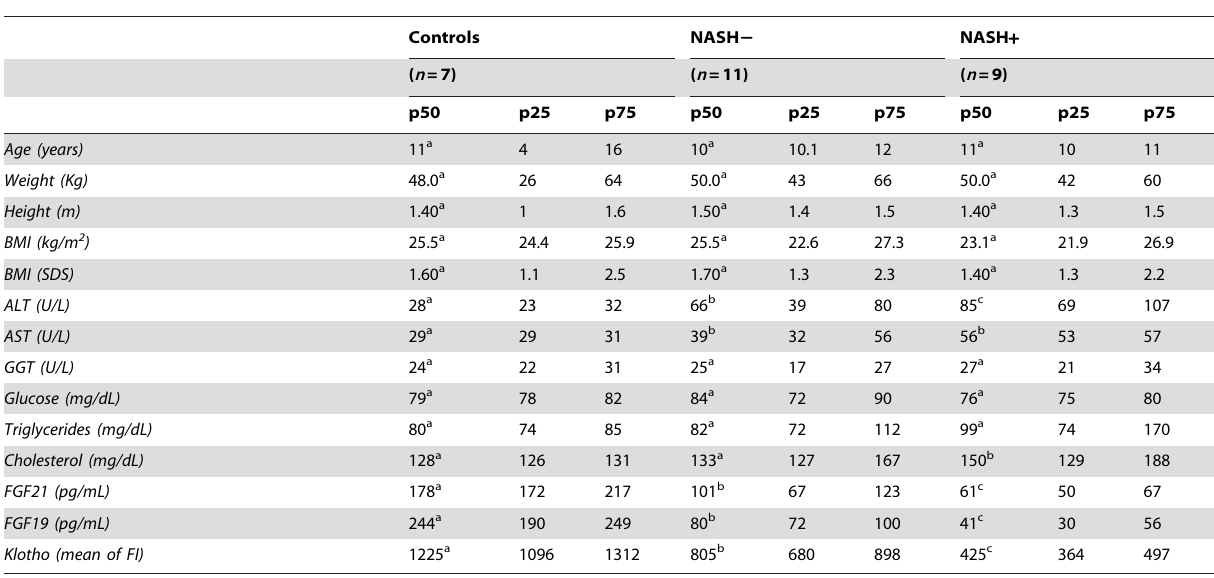
Table 3. Measurements of children evaluated in the Klotho